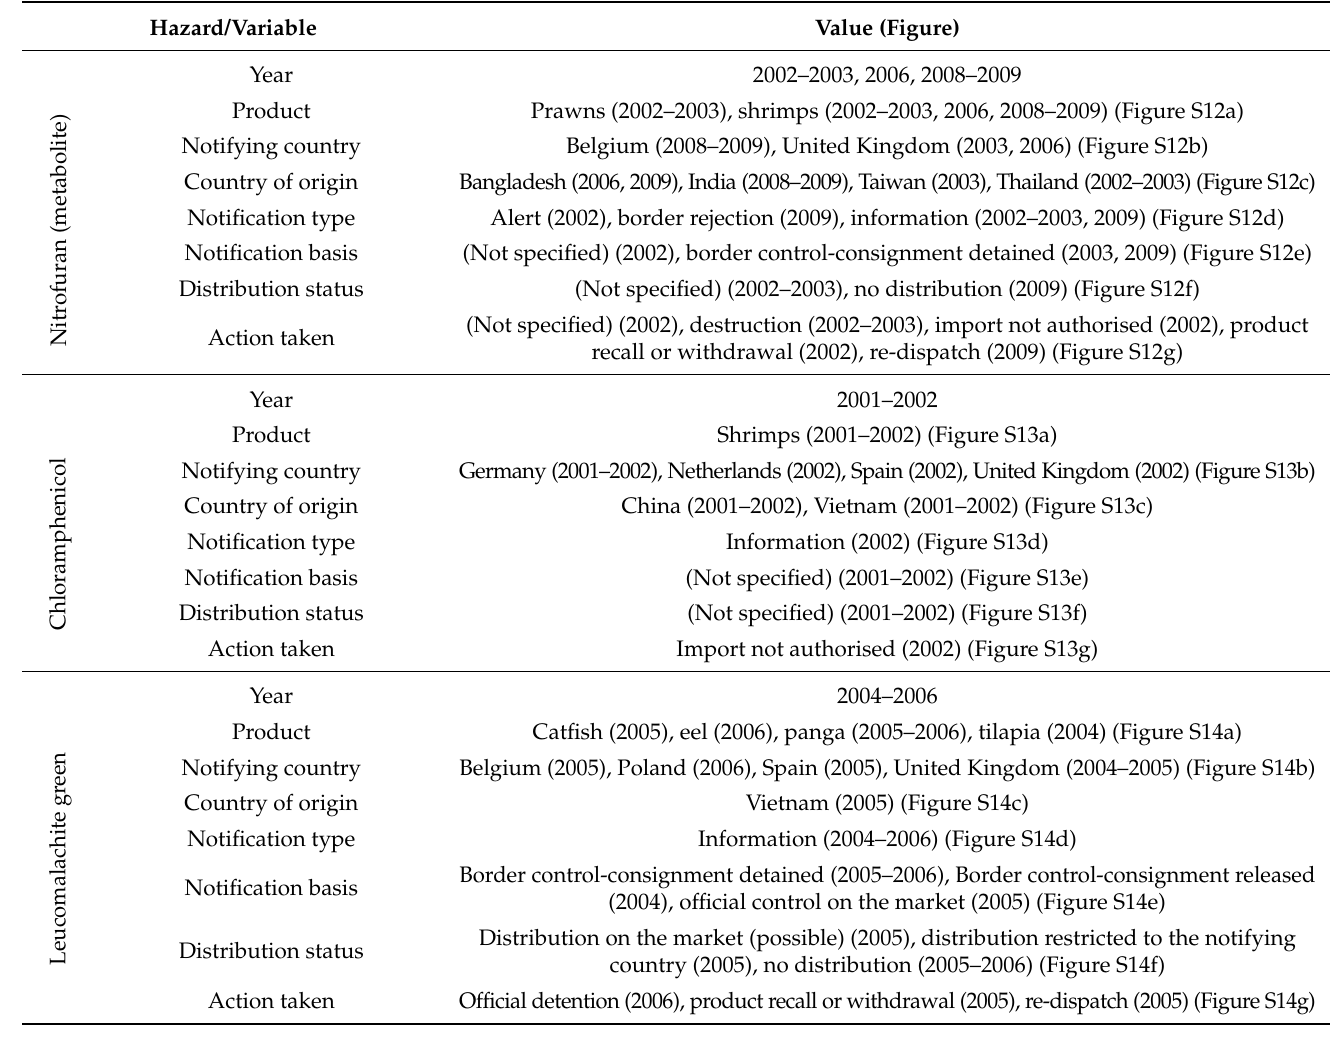
Table 8. Results of two-way joining cluster analysis related to notifications on controls in seafood